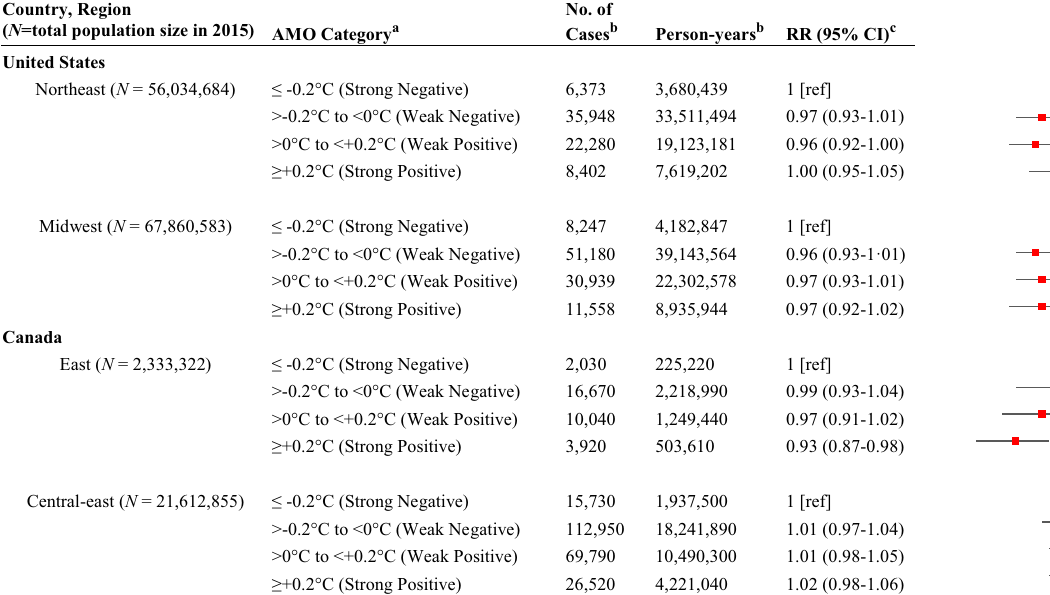
Country, Region ( N =total population size in 2015) AMO Category a